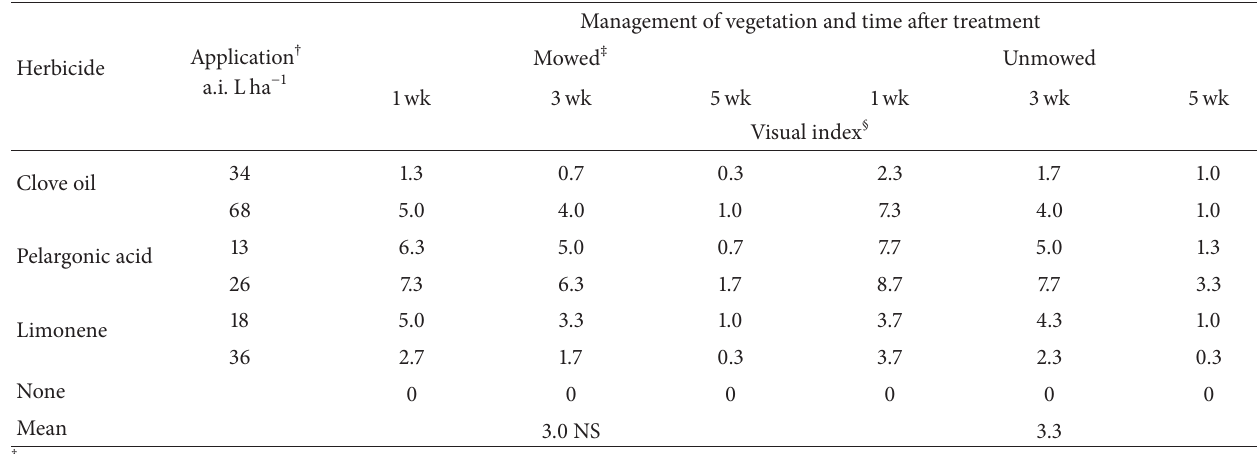
Table 10: Assessment of control of vegetation by alternative herbicides applied at two concentrations to mowed or unmowed plots in roadside research (Roadside Experiment 1).